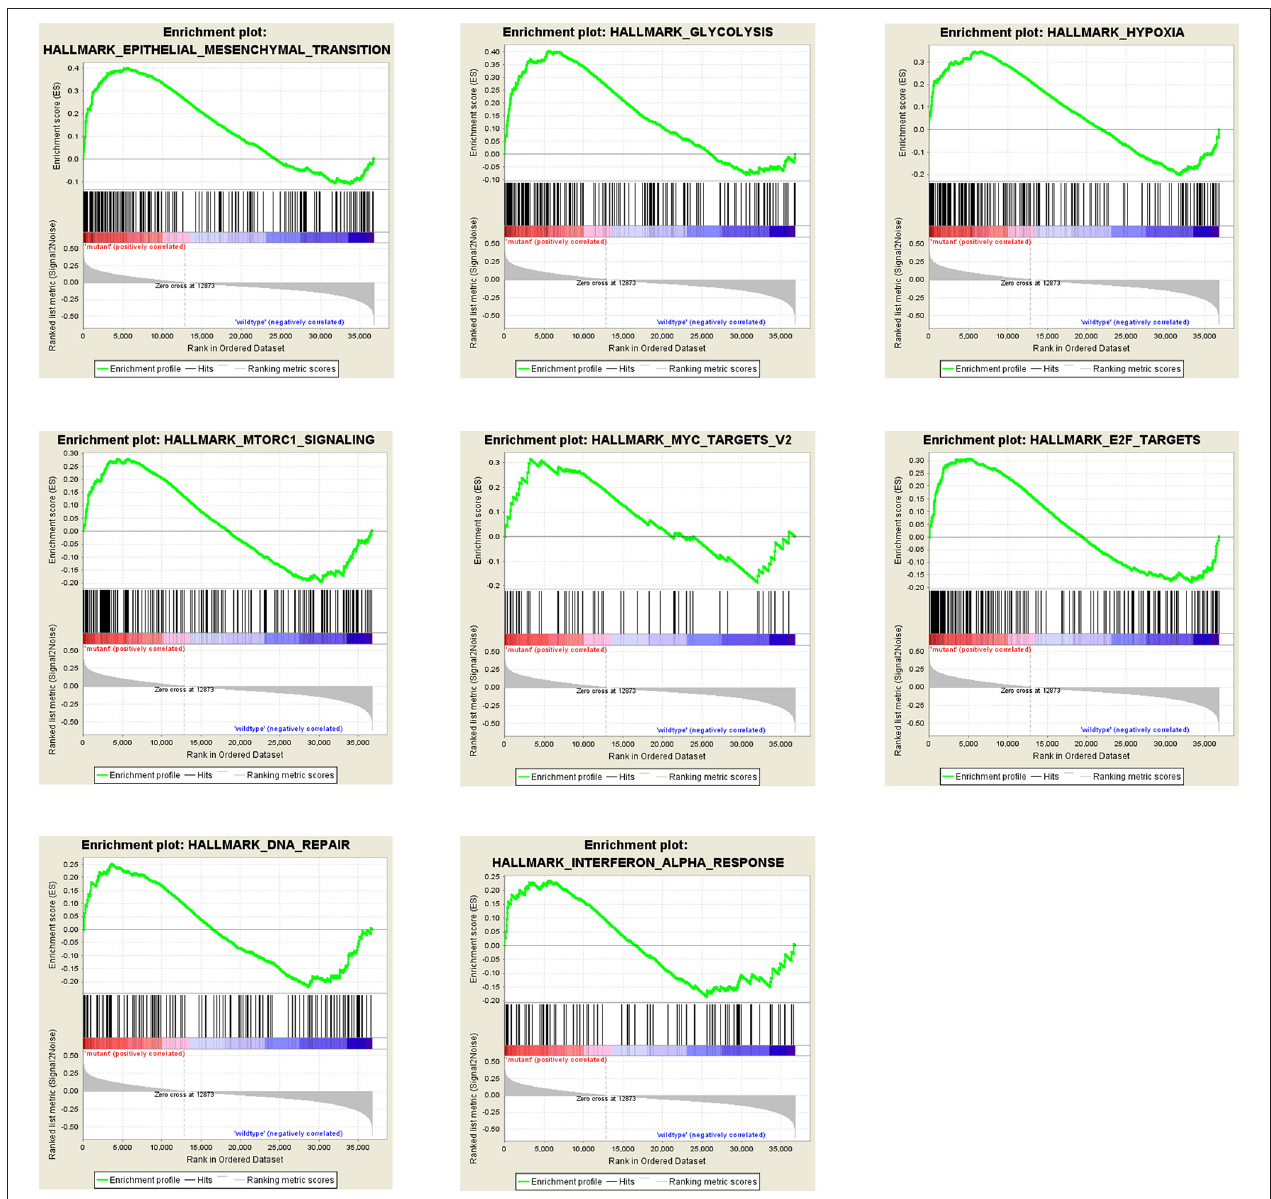
FIGURE 3 | GSEA results of the PTEN mutation in ccRCC